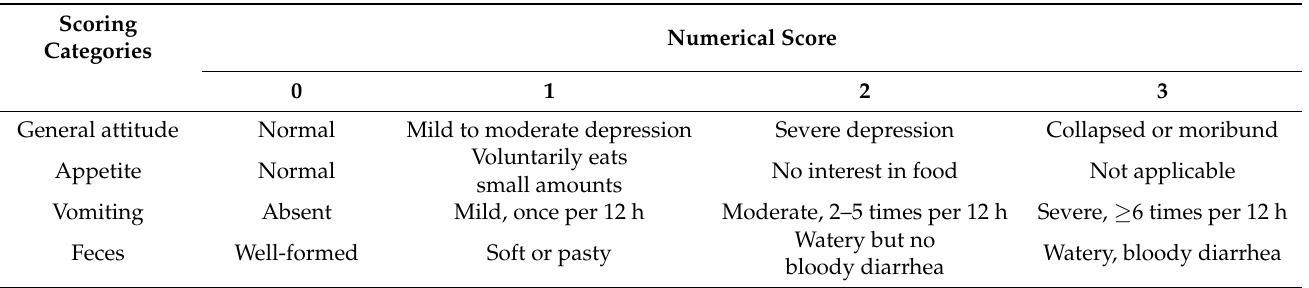
Table 1. Clinical scoring system used to quantify the disease severity in dogs with parvoviral enteritis